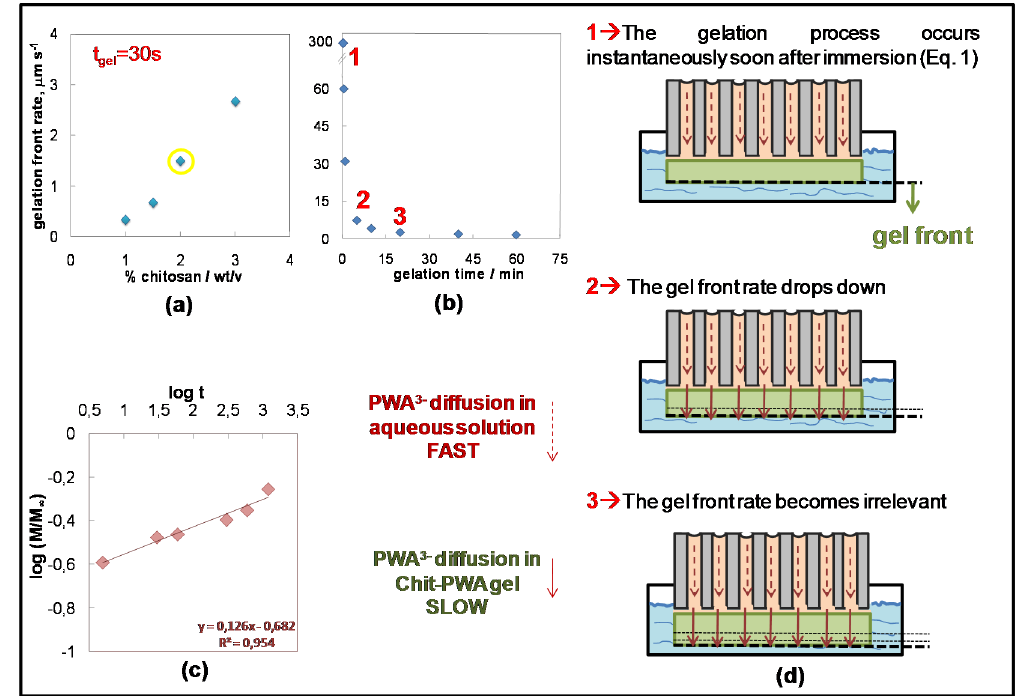
Figure 3. Gelation front rate as a function of ( a ) chitosan concentration; and ( b ) gelation time at 2% wt / v Chit. ( c ) Curves of log versus log(t) for Chit-PWA composite structures at 2% wt / v Chit. The linear equation can be applied only for log(Mt / M ∞ ) ≤ 0.22. ( d ) Scheme illustrating the growth steps of